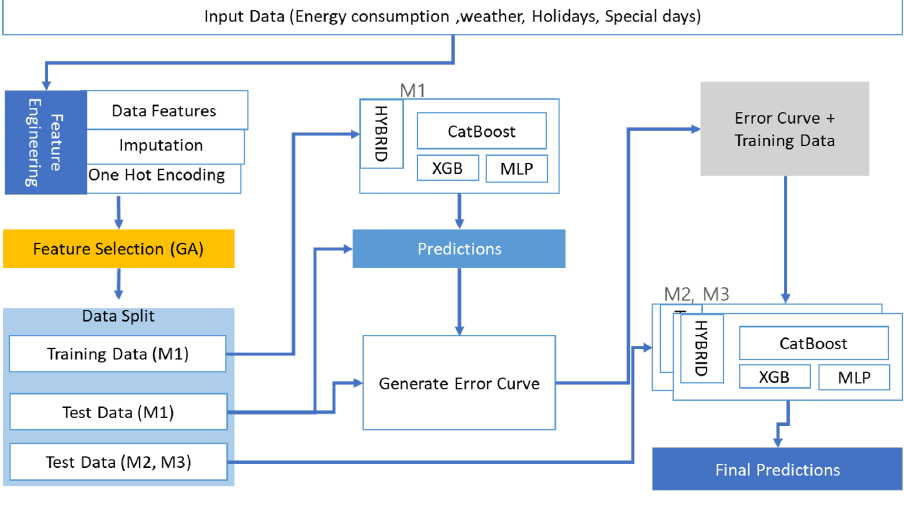
Figure 1. Flow diagram of error curve learning-based prediction